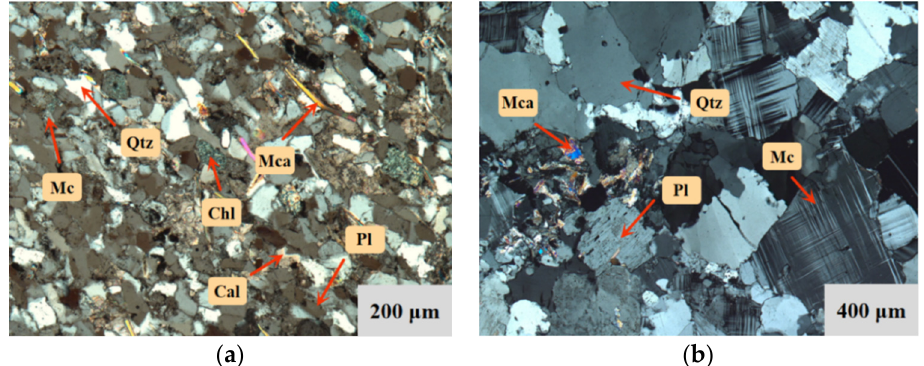
Figure 1. Thin sectional image of specimen meso-structure. ( a ) Quartz sandstone. ( b ) Granite.